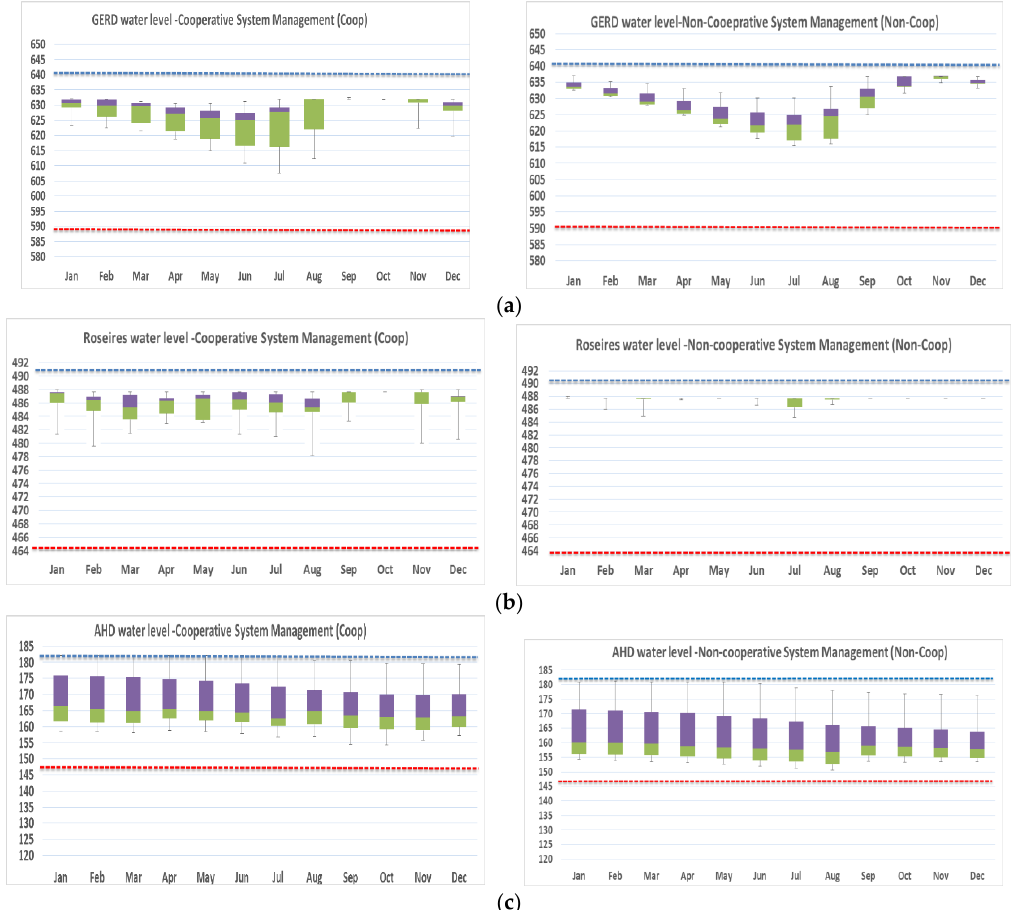
Figure 7. Boxplot of the monthly water level of GERD ( a ), Roseires ( b ), and AHD ( c ) for both cooperative (Coop) and non-cooperative (Non-Coop) Eastern Nile system optimization, under normal hydrological conditions.